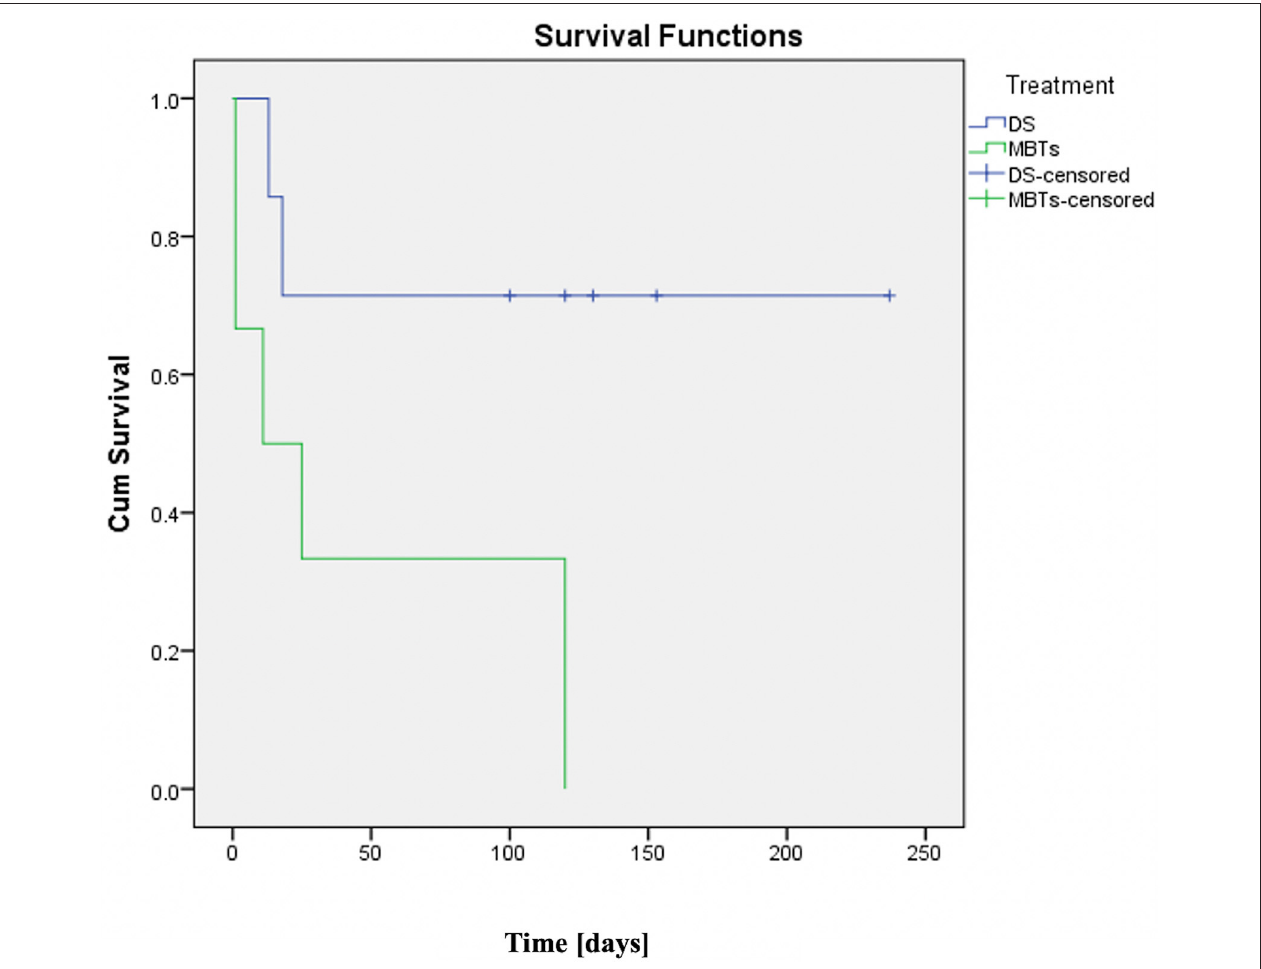
FIGURE 3 | Kaplan-Meier curve (DS vs. MBTs in patients with PA-IVS and right ventricle-dependent coronary perfusion). DS group showed better survival rates compared with the MBTs group which had very low survival. No patient in this group has reached the next surgery. Time since procedures is indicated in days.